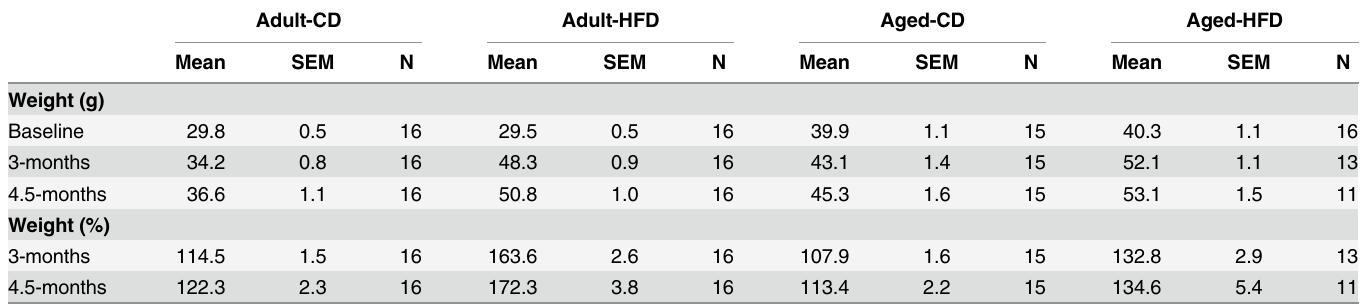
Table 1. Effects of age and diet on weight (g) and weight gain (% of